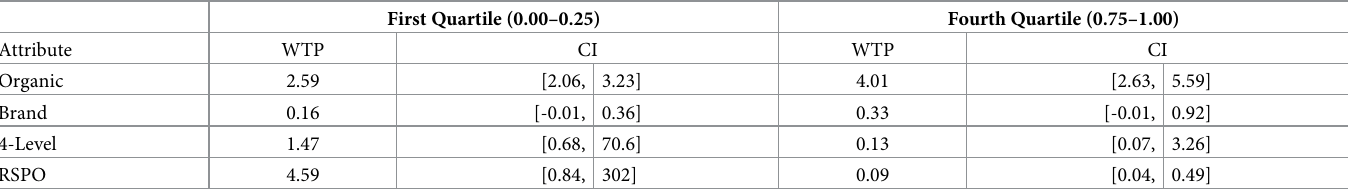
Table 9. Willingness-to-pay estimates first and fourth quartile of predicted LV, information